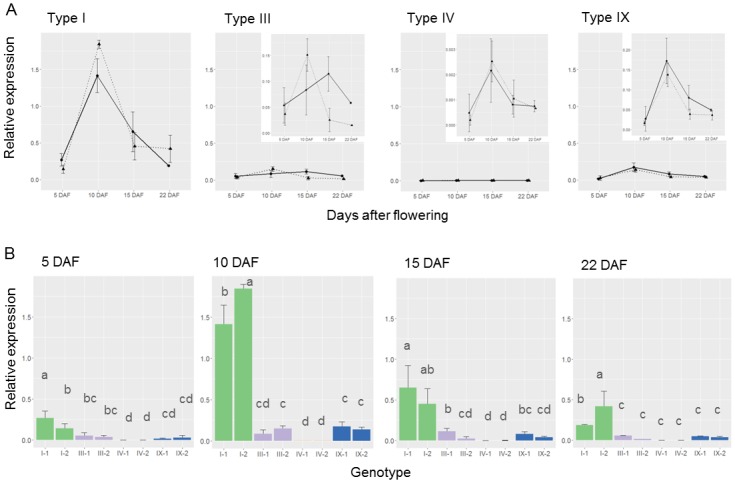
Gene expression of Wx and quantity of GBSSI protein for different Wx genotypes.(A) Expression levels of Wx at different seed development stages. The relative expression levels of four Wx genotypes, each represented by two accessions indicated by solid and dotted lines, were estimated at 5, 10, 15, and 22 DAF. Inserts on the right corners of figures of three mutated genotypes are the original expression patterns drawn without normalized scales. (B) Comparison of expression levels of Wx genotypes at different endosperm development stages. Genotype I, III, IV, and IX are represented by green, violet, orange (could be seen at 10 DAF, but not in other three stages), and blue, respectively. Means with different superscripts are significantly different at p<5%, according to Fisher’s LSD test.